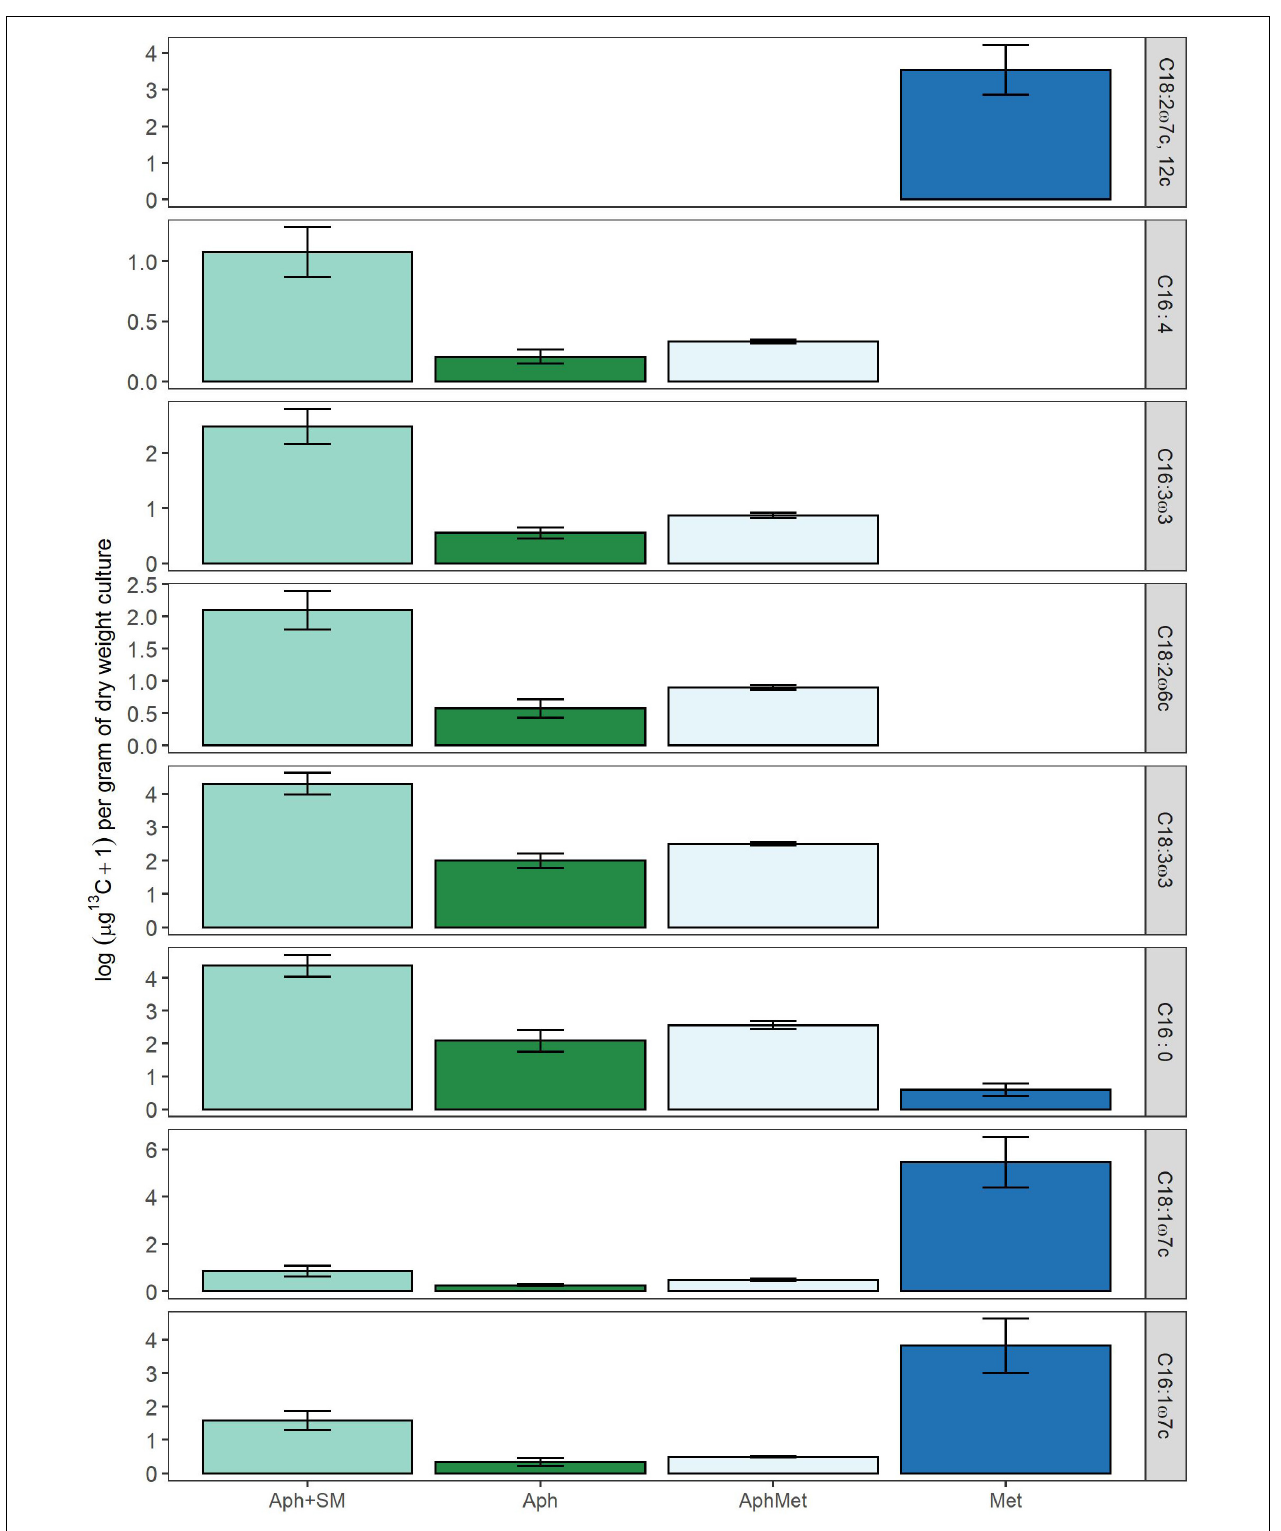
FIGURE 6 | Log 13 C content, as assimilated in individual PLFA molecules in mono- or co-cultures of Aphanizomenon (Aph) or Methylosinus (Met) expressed as µ g of 13 C per dry weight of total culture used in PLFA extraction. If 13 C incorporation in this figure is higher than 0, the PLFA is enriched compared to control with 12 C only. Aph + SM represents monocultures of Aphanizomenon with spent medium added originating from a Methylosinus monoculture grown with 13 C methane. The δ 13 C PLFA of labeled and unlabeled control samples was used to calculate the excess amount of 13 C in each PLFA biomarker. Bars represent means ( n = 4) ± 1 SE.